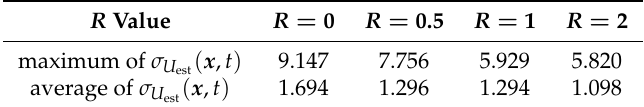
( l ) = U ( l ) for different R . i , t i , t ξ